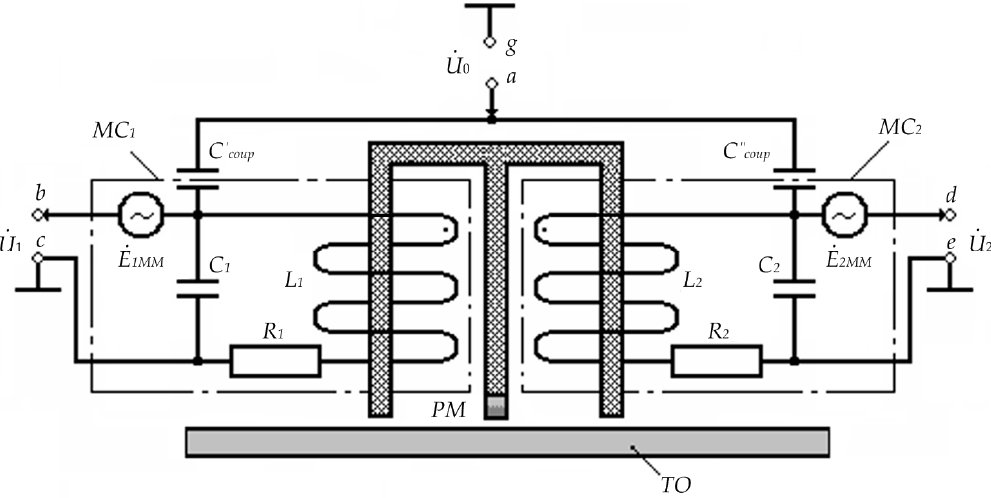
Figure 5. Circuit Diagram of the FS Substitution and Inclusion for the Third Mode.